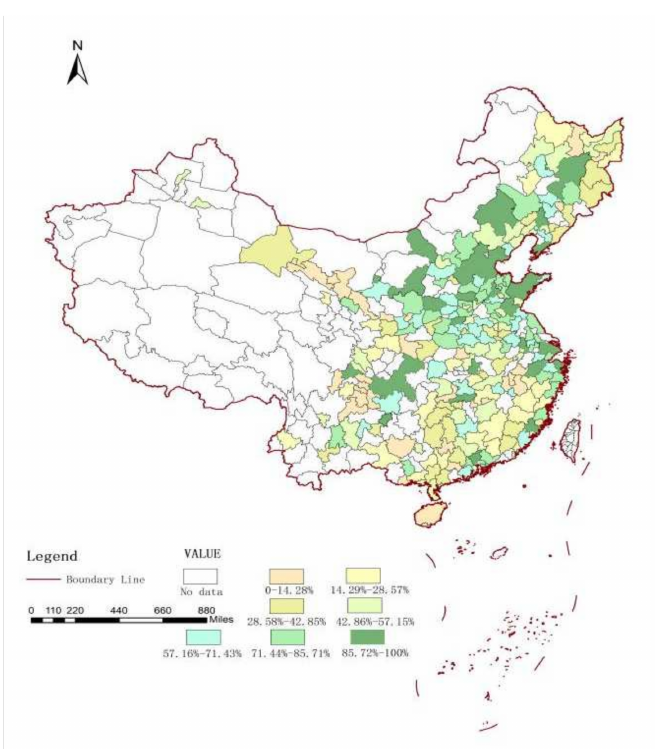
Figure 2. Carbon intensity in China,